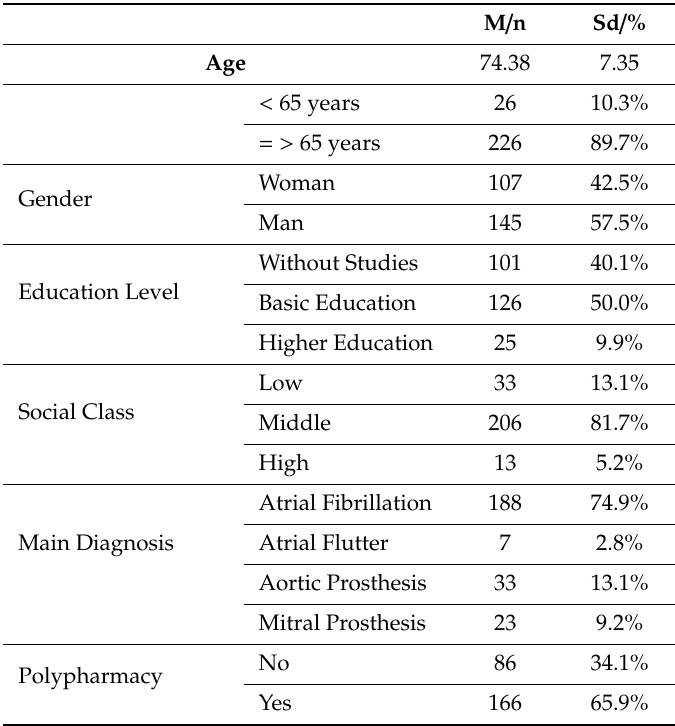
Table 1. Characteristics of participants.